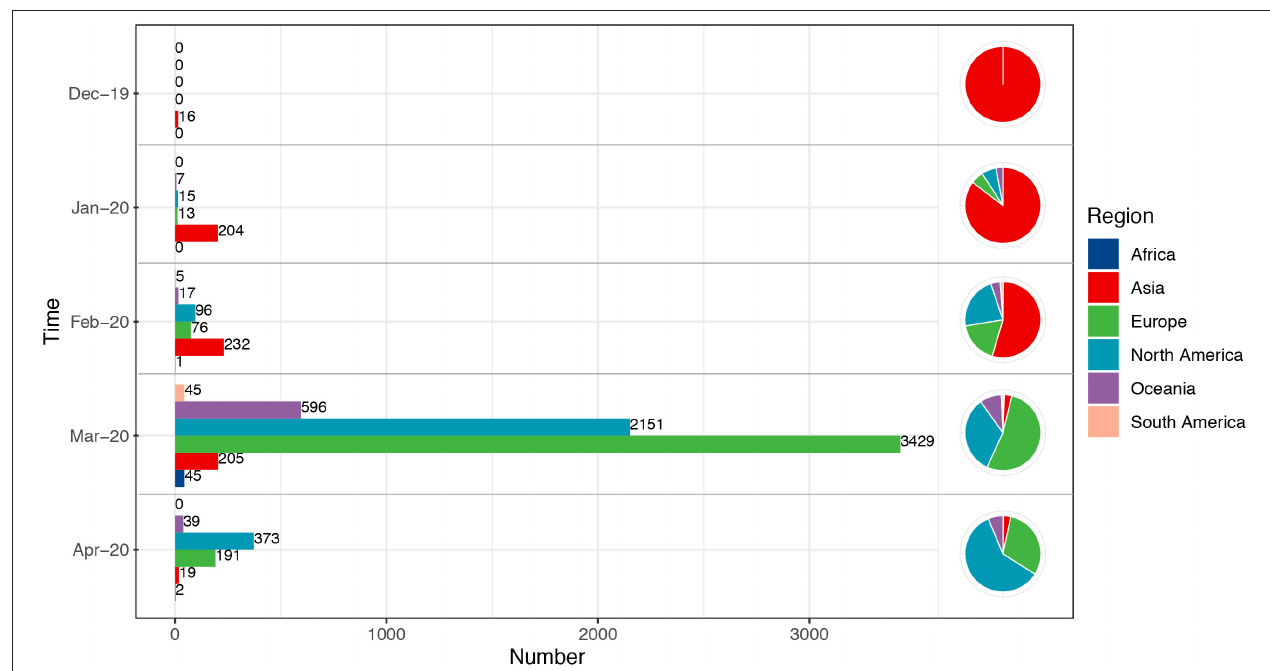
FIGURE 1 | Temporal and geographical distributions of all sequences. All the sequences selected in this study were classified according to the transmission course and region. Time referred to the collection date of the samples, which were divided into groups by month from December 2019 to April 2020. Each group included the total number of all sequences in related month. Regions were classified by continent, including Africa, Asia, Europe, North America, South America, and Oceania. Number referred to the number of sequences. The sequences from December 2019 to February 2020 were concentrated in Asia, and the subsequent cases in March and April were mainly in Europe and North